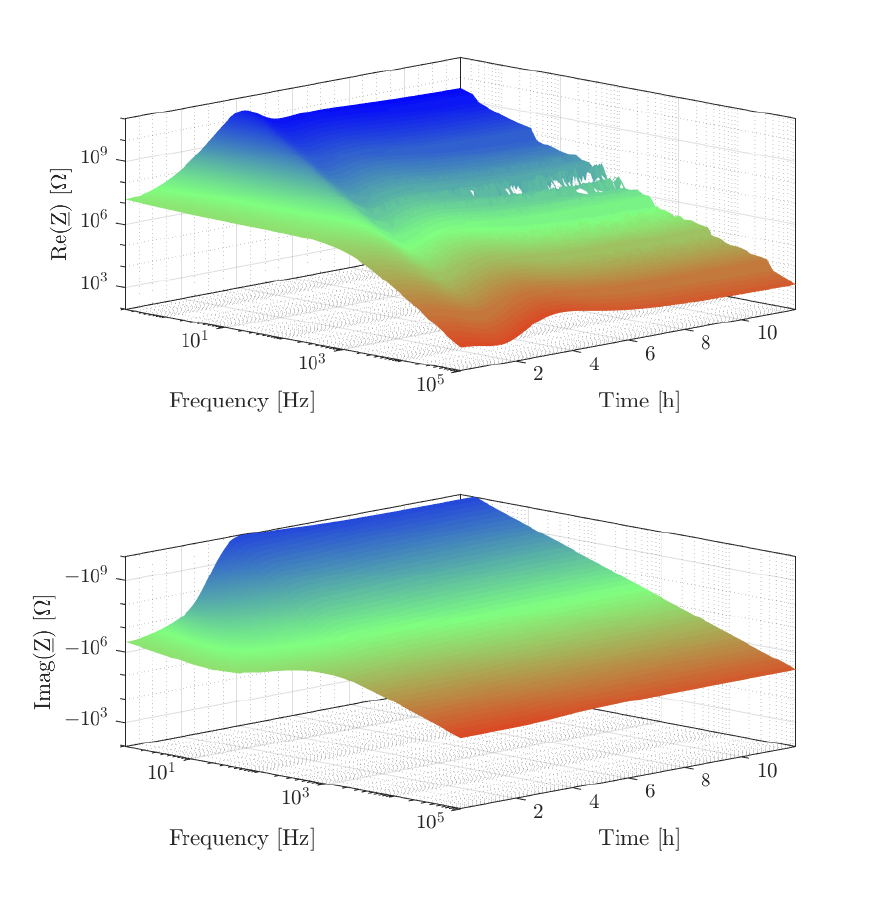
Figure 6. Measured impedance spectra during 12h curing of pure resin specimen consisting of RIMR426 with RIMH435 hardener. The upper panel displays the real part of the complex impedance, the lower panel displays the imaginary part. The imaginary part is negative because of the capaci- tive